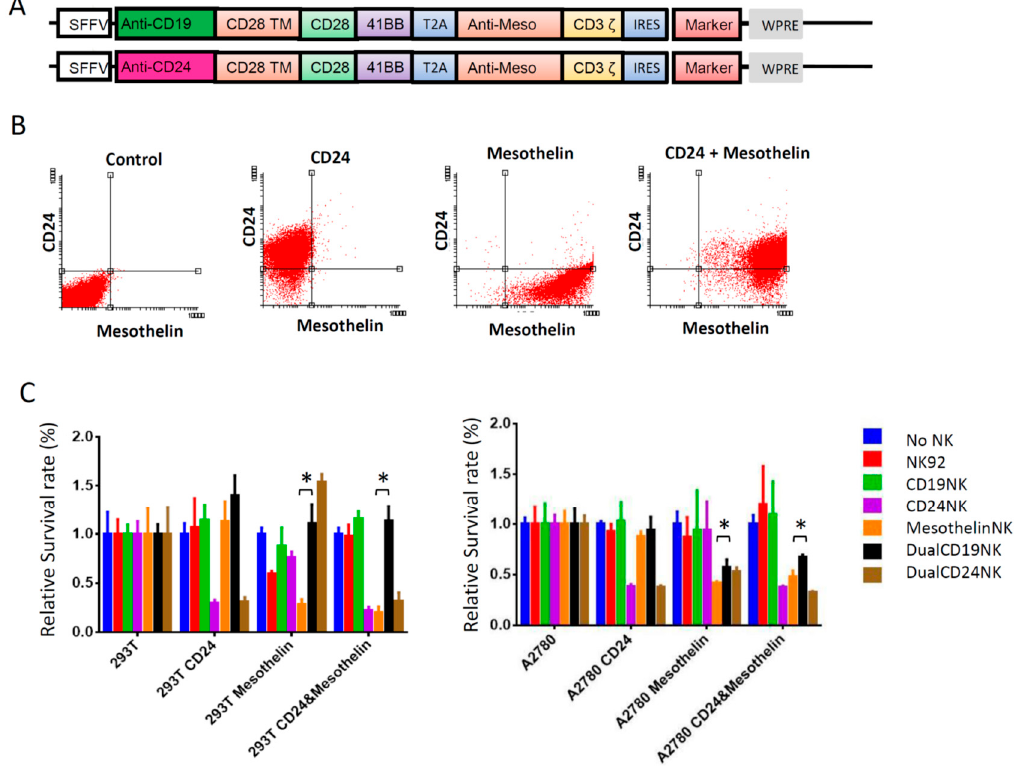
Figure 5. Anti-CD24/anti-mesothelin dual-CAR-NK-92 cells show killing activity against cancer cells expressing both antigens. ( A ) Schematic illustration of the structure of the dual-CAR based on the concept of Wilkie et al. [18]. The co-stimulatory domains are split over both CARs. The anti-CD24 scFv is fused to the CD28 and 4-1BB domains. The anti-mesothelin scFv is fused to the CD3 ζ signaling domain. The two CARs are connected via a T2A sequence to allow equal expression of both from a single promoter. ( B ) FACS analysis of HEK293T cells which were previously transduced with the respective antigens. ( C ) Results of a FluoroSkan-based assay. CD24, mesothelin or CD24 and mesothelin expressing HEK293T and A2780 cells were co-incubated with the different NK-92 cells targeted against the indicated antigens at an E/T ratio of 5:1 over 24 h. * indicate p < 0.005 (unpaired t -test). Values represent the mean from three different samples of two separate experiments.